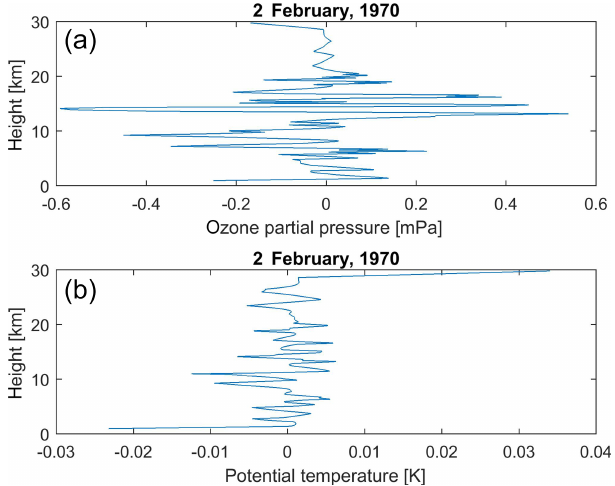
Figure 2. Differences between real and smooth vertical profiles from 2 February 1970 for ozone (a) and potential temperature (b)